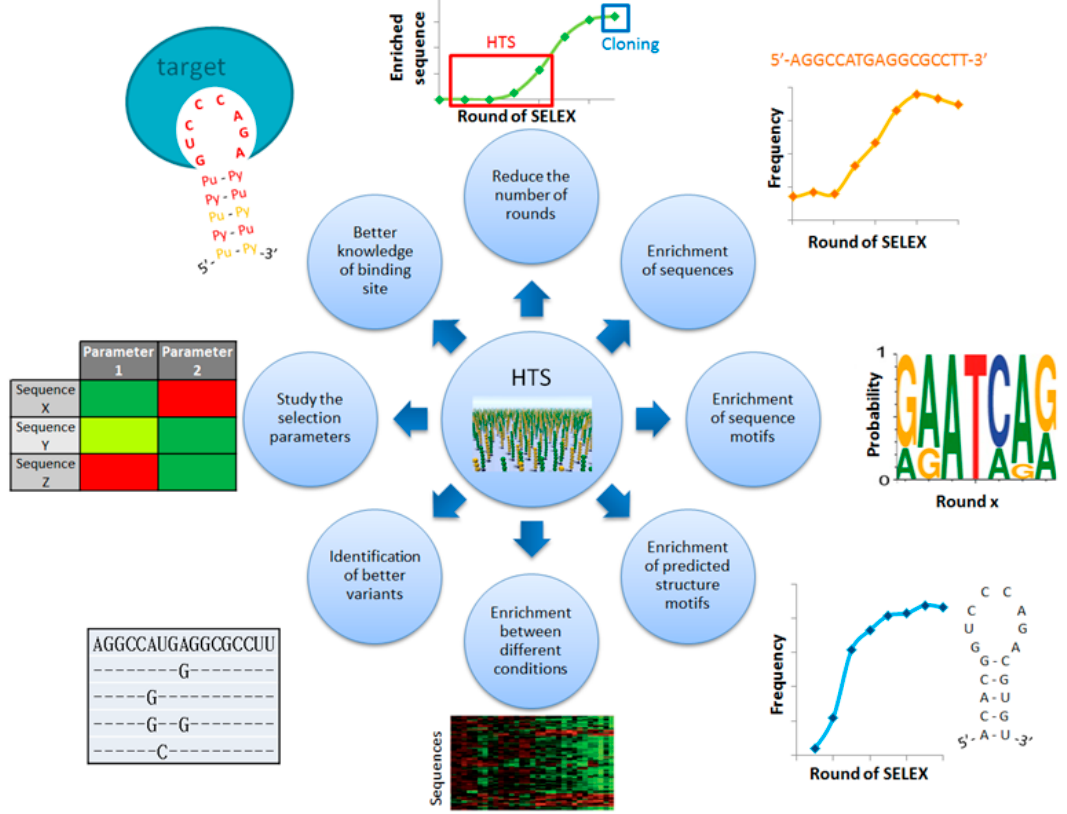
Figure 1. Improvements of aptamers identification and characterization with the use of High-Throughput Sequencing. HTS analysis can investigate faster the enrichment of (sub-)sequences or predicted (sub-)structures. Variants of a same family sequence can be compared in order to extract mutants with higher affinity than the most abundant sequence. It is possible to more precisely characterize the interaction between aptamers and their targets by analyzing different conditions of selection (for instance, incubation with target’s variants or varying the composition of binding buffer). It is also possible to find aptamers specific for a defined condition. Finally, the impact of each selection parameter can be studied which could help to improve the SELEX experiments in the